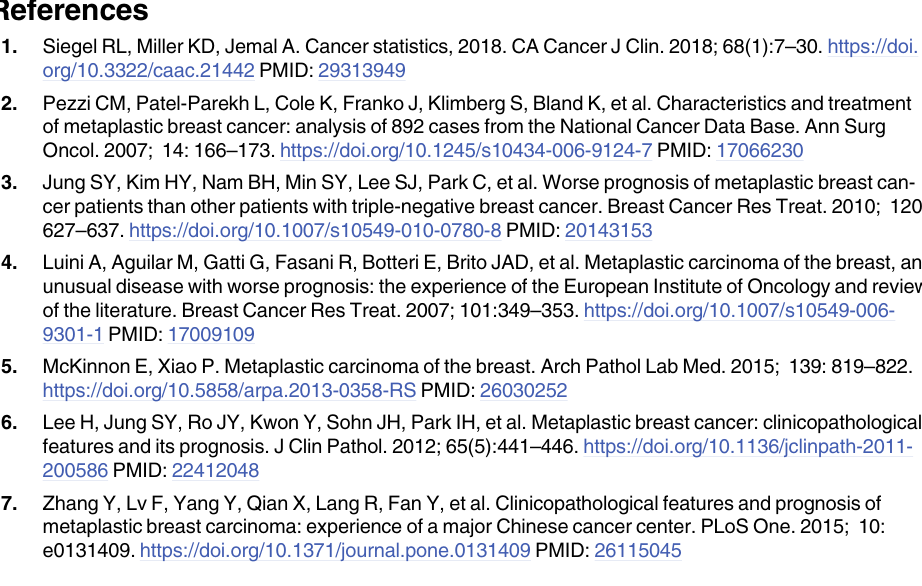
S1 Table. Prognostic factors for OS and BCSS in univariate analysis. S2 Table. Subgroup analysis of OS and BCSS in univariate analysis. S1 Fig. OS of MBC patients displayed as Kaplan–Meier curves according to surgical method for different patient